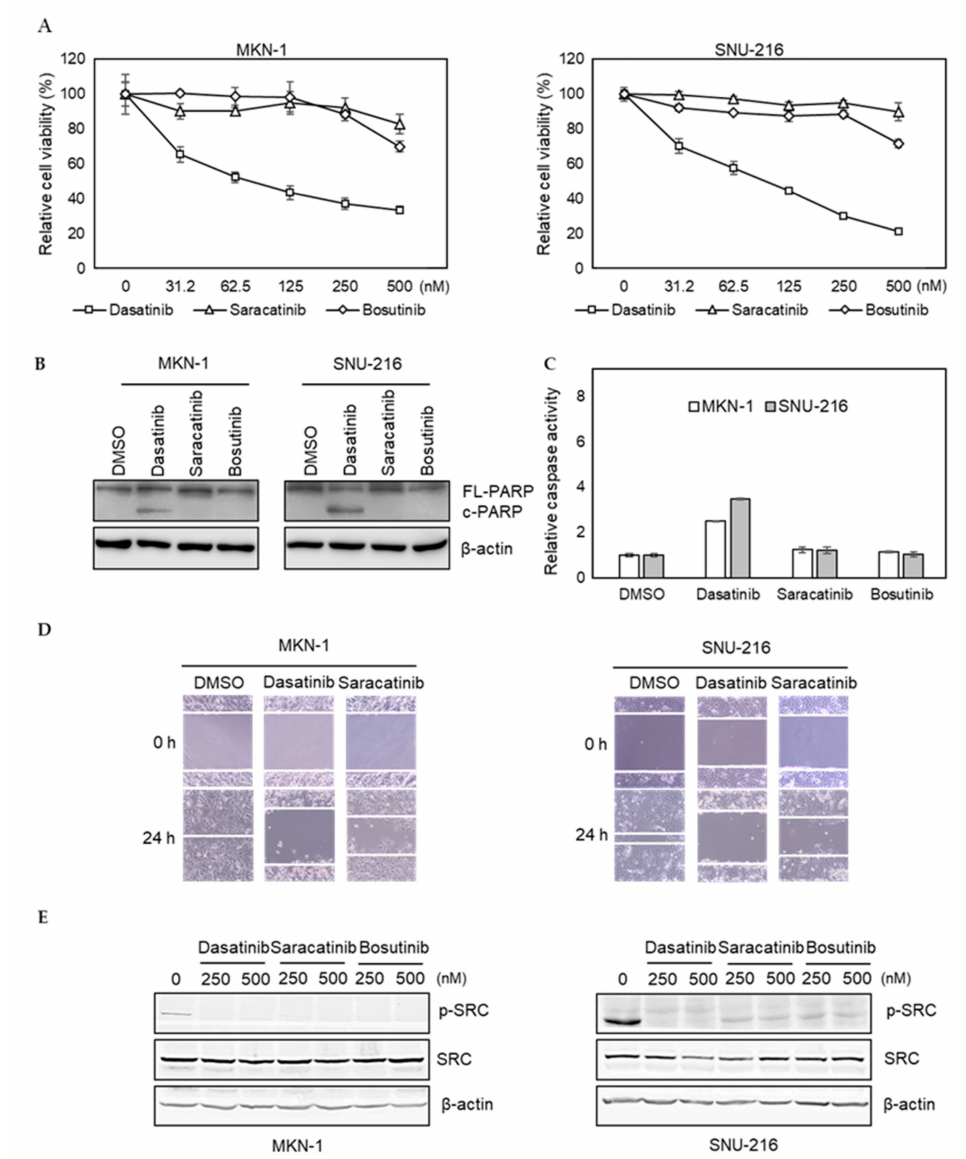
Figure 2. Comparison of dasatinib e ff ect with other SRC inhibitors in GC cell lines. ( A ) Relative viabilities of GC cells in response to dasatinib, saracatinib, and bosutinib. Cells were treated with di ff erent doses of drugs (0 to 2.5 µ M) for 72 h, and the cell viability was assessed by MTT assay. Error bars represent standard deviation from representative triplicate experiments from at least three experiments that showed similar results. ( B ) Cells were treated with 500 nM of drugs for 48 h, and PARP cleavage and SRC levels were analyzed by Western blotting. FL-PARP: full length PARP; c-PARP: cleaved PARP; p-SRC: phospho-SRC (Y416). ( C ) Cells were treated with 500 nM of drugs for 24 h, then caspase activity was analyzed using a Caspase Glo 3 / 7 assay kit. Relative caspase activities are shown. Error bars represent standard deviation from representative triplicate experiments from at least three experiments that showed similar results. ( D ) Cells were treated with vehicle control (DMSO) or 250 nM of drugs for 24 h, then cell migration was analyzed by wound healing assay. ( E ) Cells were treated with 250 nM or 500 nM of drugs for 1 h, and phospho- (Y416) or total SRC levels were analyzed by Western